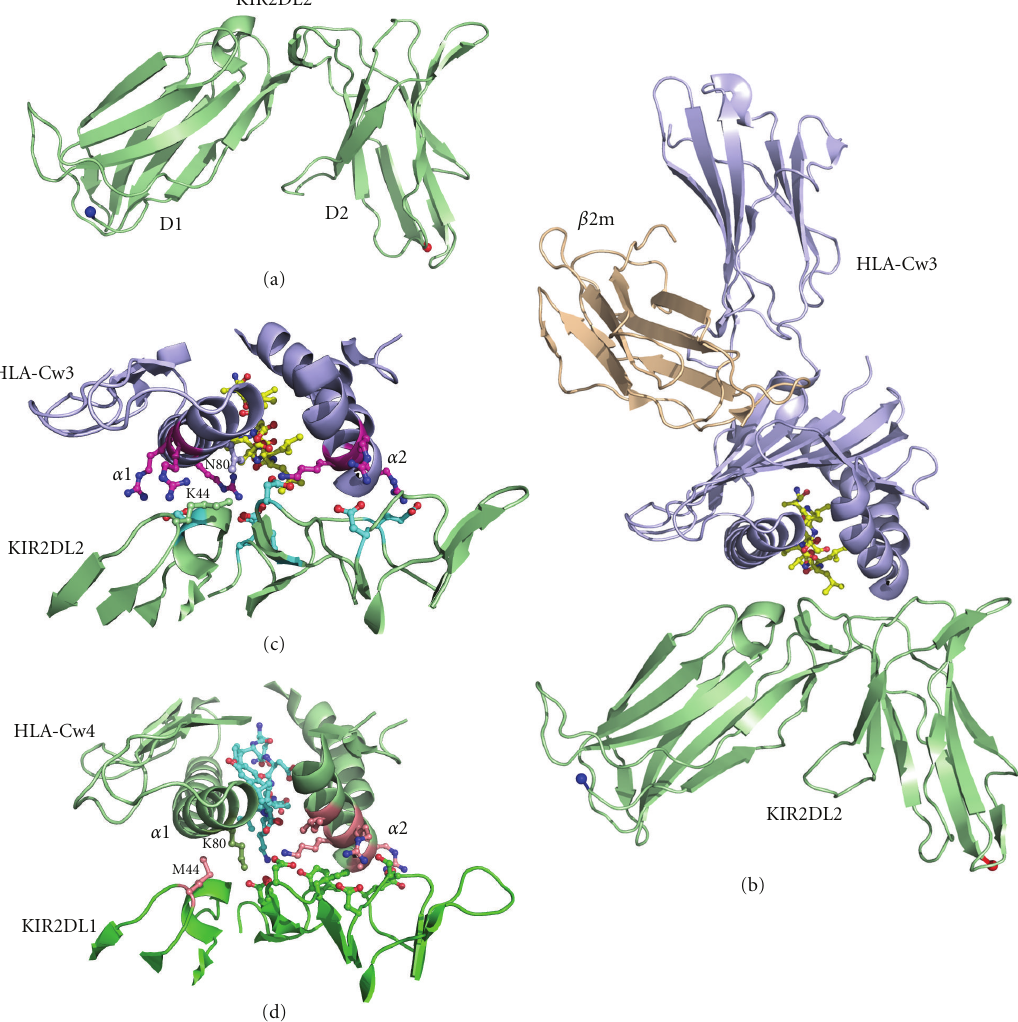
Figure 2: Structure of inhibitory KIR molecules. (a) Structure of KIR2DL2 which is made up of two C2-like domains is shown in cartoon representation with the N-terminus and C-terminus described by a blue and red sphere, respectively. (b) Structure of KIR2DL2 in complex with the MHC class I molecule HLA-Cw3 and β 2m shown in cartoon representation with bound peptide shown in ball and stick representation with yellow carbon atoms. (c) Closeup of the HLA-Cw3:KIR2DL2 interface with interacting residues displayed in ball and stick representation. The bound peptide is shown with yellow colored carbon atoms while the interacting residues from HLA-Cw3 are shown in purple and those from the KIR molecule are shown in o ff -white coloring. The critical residues for HLA-KIR specificity, K44 from KIR 2DL2 and N80 from HLA Cw3 are shown in green and light-blue, respectively. (d) Closeup of the HLA-Cw4:KIR2DL1 interface with interacting residues displayed in ball and stick representation. The bound peptide is shown with white carbon atoms while the interacting residues from HLA-Cw4 have green carbon atoms and those from KIR 2DL1 have yellow carbon atoms. The critical residues for HLA-KIR specificity, M44 from KIR 2DL1, and K80 from HLA Cw4 are shown in dark green and light green,